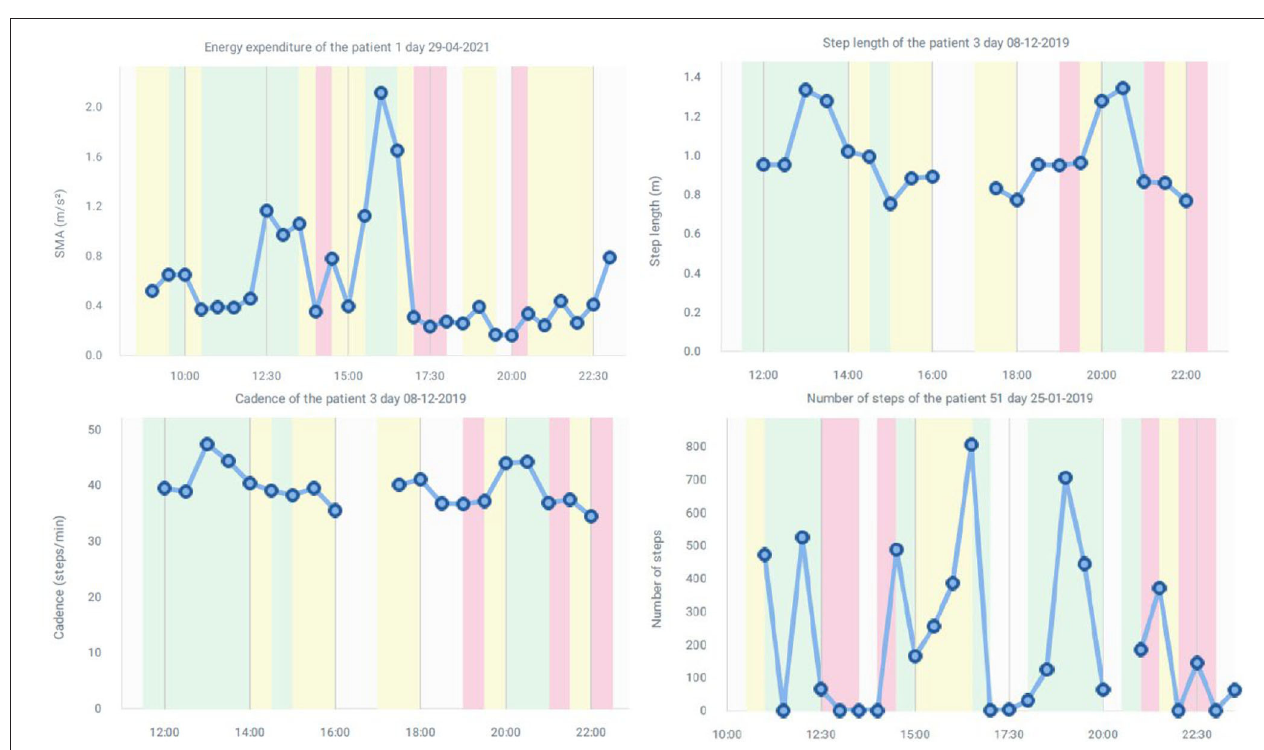
FIGURE 8 | Some graph examples of the extended